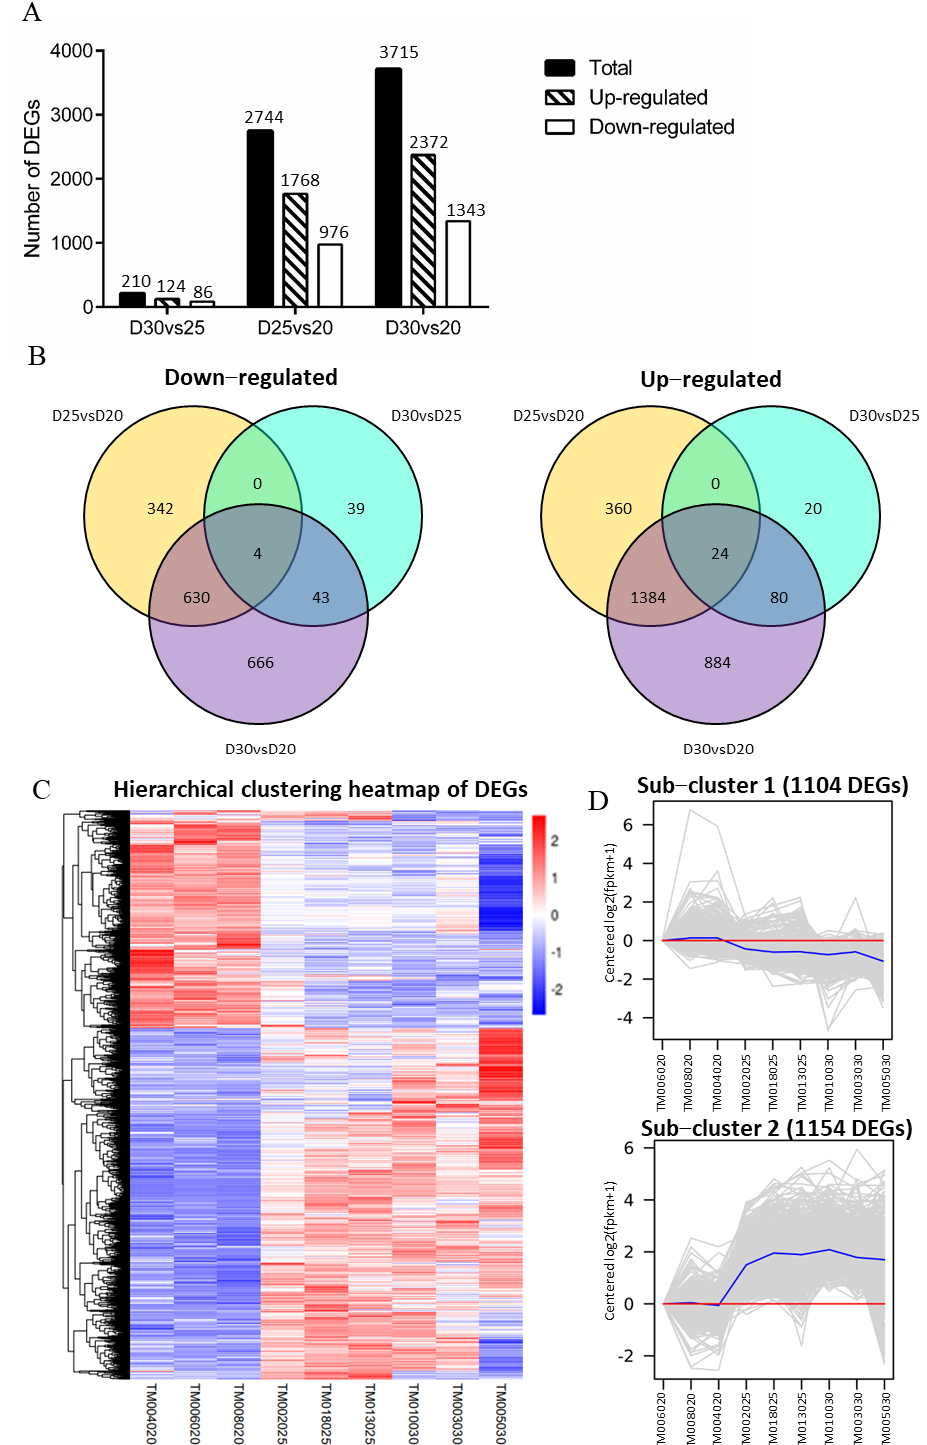
Figure 3. Screening of DEGs in hircine trophoblasts at three-time points of early gestation. ( A ). Quantification of DEGs number in down- and up-regulated portion in the pairwise comparison from three-time points of early pregnancy. ( B ). Venn diagrams illustration of trophoblastic DEGs at three stages of early pregnancy. Left side, down-regulated DGEs. Right site, up-regulated DGEs. ( C ). Hierarchical clustering heatmap of all DEGs performed on nine samples at three-time points of pregnancy. ( D ). The clustering analysis of the expression patterns in down- and up-regulated DEGs.